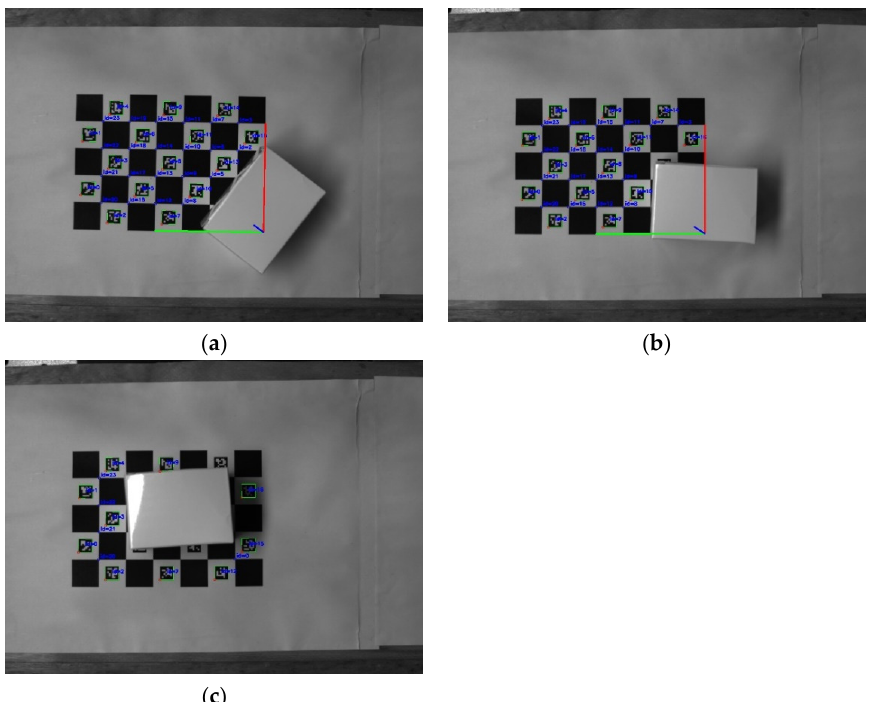
Figure 4. Calculation results of camera extrinsic parameters based on ChArUco board, under different occlusion conditions: ( a , b ) Calculation results of camera extrinsic parameters for small area occlusion; ( c ) Calculation results of camera extrinsic parameters for large area occlusion.